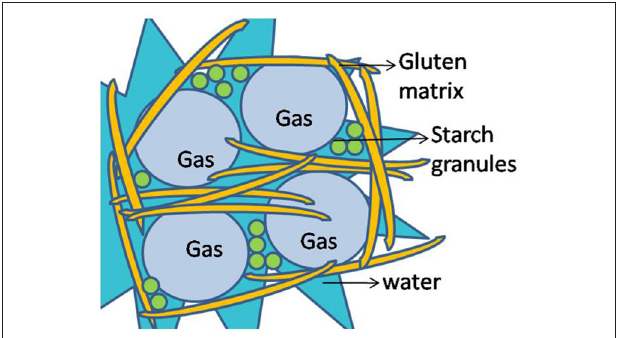
FIGURE 1 | Illustration of gas molecules entrapped in the gluten matrix of wheat